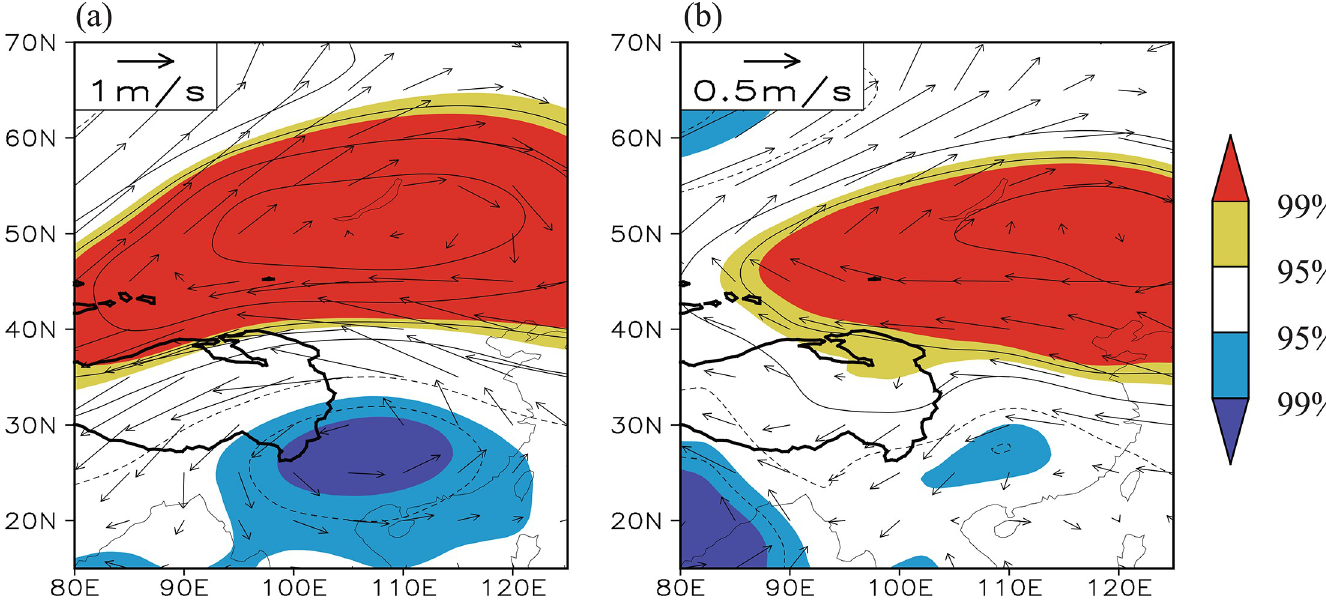
Fig 7. (a) Distribution of the correlation coefficients between the Tibetan Plateau–Lake Baikal dipole index and the simultaneous 200 hPa geopotential height field, in which the 200 hPa wind anomalies regressed against the Tibetan Plateau–Lake Baikal dipole index are represented by black vectors. (b) Distribution of the correlation coefficients between the Tibetan Plateau–Lake Baikal dipole index and the simultaneous 600 hPa geopotential height field, in which the 600 hPa wind anomalies regressed against the Tibetan Plateau–Lake Baikal dipole index are represented by black vectors. The solid contour denotes areas higher than 3000 m altitude. The yellow (red) shading denotes a positive correlation significant at the 95% (99%) confidence level and the blue (purple) shading represents a negative correlation significant at the 95% (99%) confidence